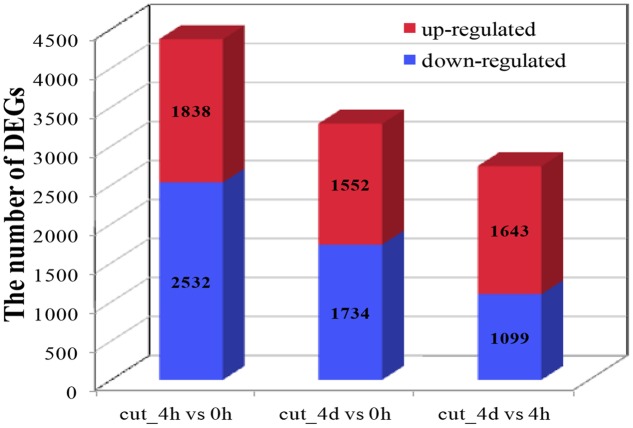
Statistics of Differentially expressed gene (DEG) numbers at different culture stages. The numbers of up-regulated and down-regulated genes in comparisons between two stages after cutting are displayed (cut_4h vs cut_0h, cut_4d vs cut_0h, and cut_4d vs cut_4h).